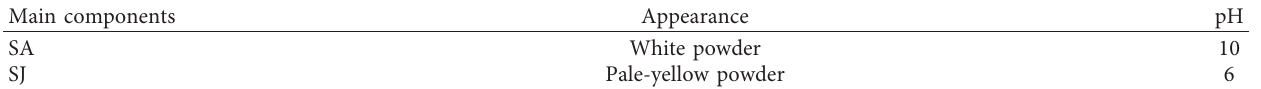
Table 2: The main characteristics of used